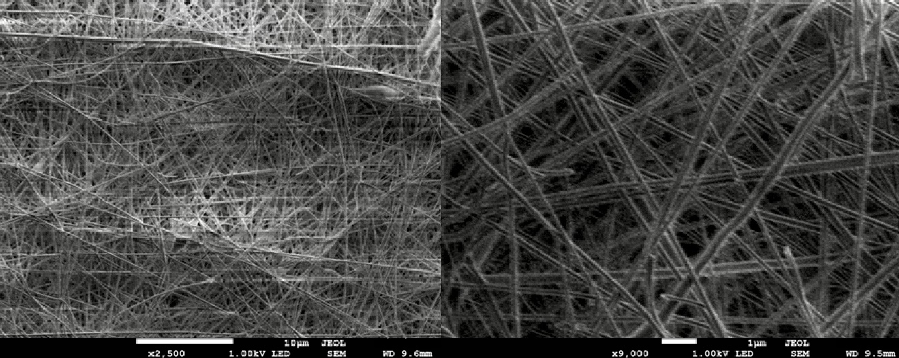
Figure 6. An example of uniform textile resulting from polymerized electro-spun V 2 O 5 with PVP + Graphene Oxide diluted in water with a 0.45 (PVP):4 ( V 2 O 5 / GO ) ratio. Reprinted from ref.